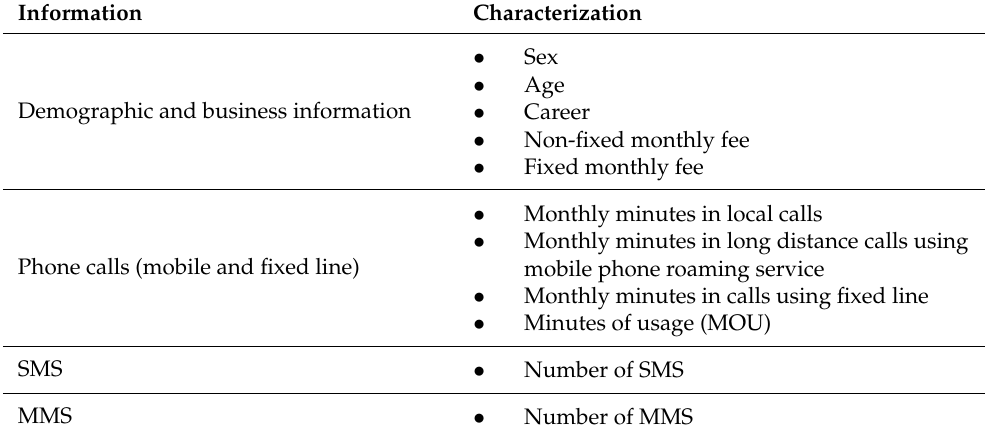
Table 2. Dataset information.